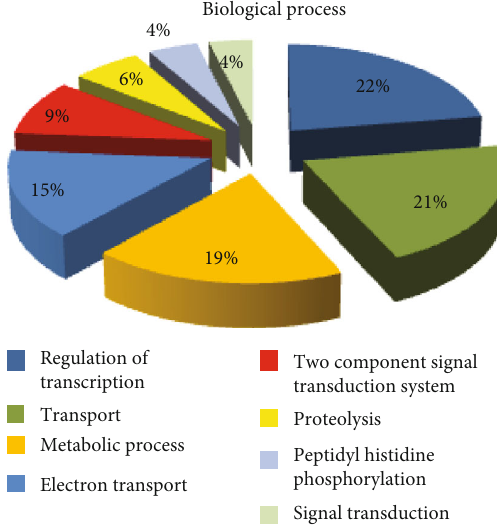
Figure 7: Gene Ontology (GO) distributions for reniform nematode genomic sequences as determined by Blast2GO and grouped by biological process for the SIGMA